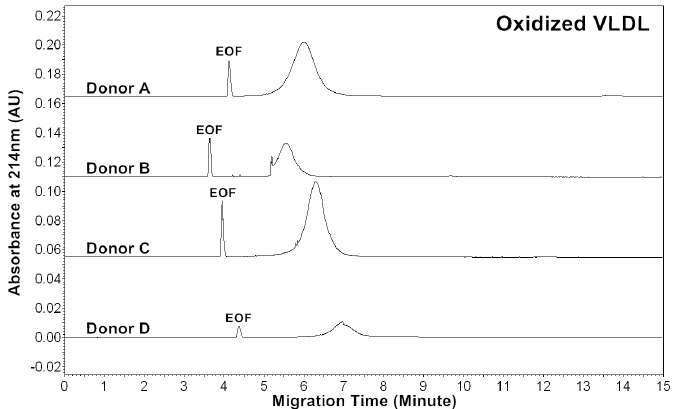
Figure 2. Electropherograms of in vitro oxidized VLDL particles of four healthy donors. VLDL was oxidized by 2.5 µM Cu 2+ in phosphate buffered saline (PBS) buffer at 37 °C for 18 h, and the buffer was then exchanged to 5 mM sodium phosphate, pH 7.40 using a 100 kDa ultrafiltration filter (MW cut-off: 100,000). CE conditions are the same as in Figure